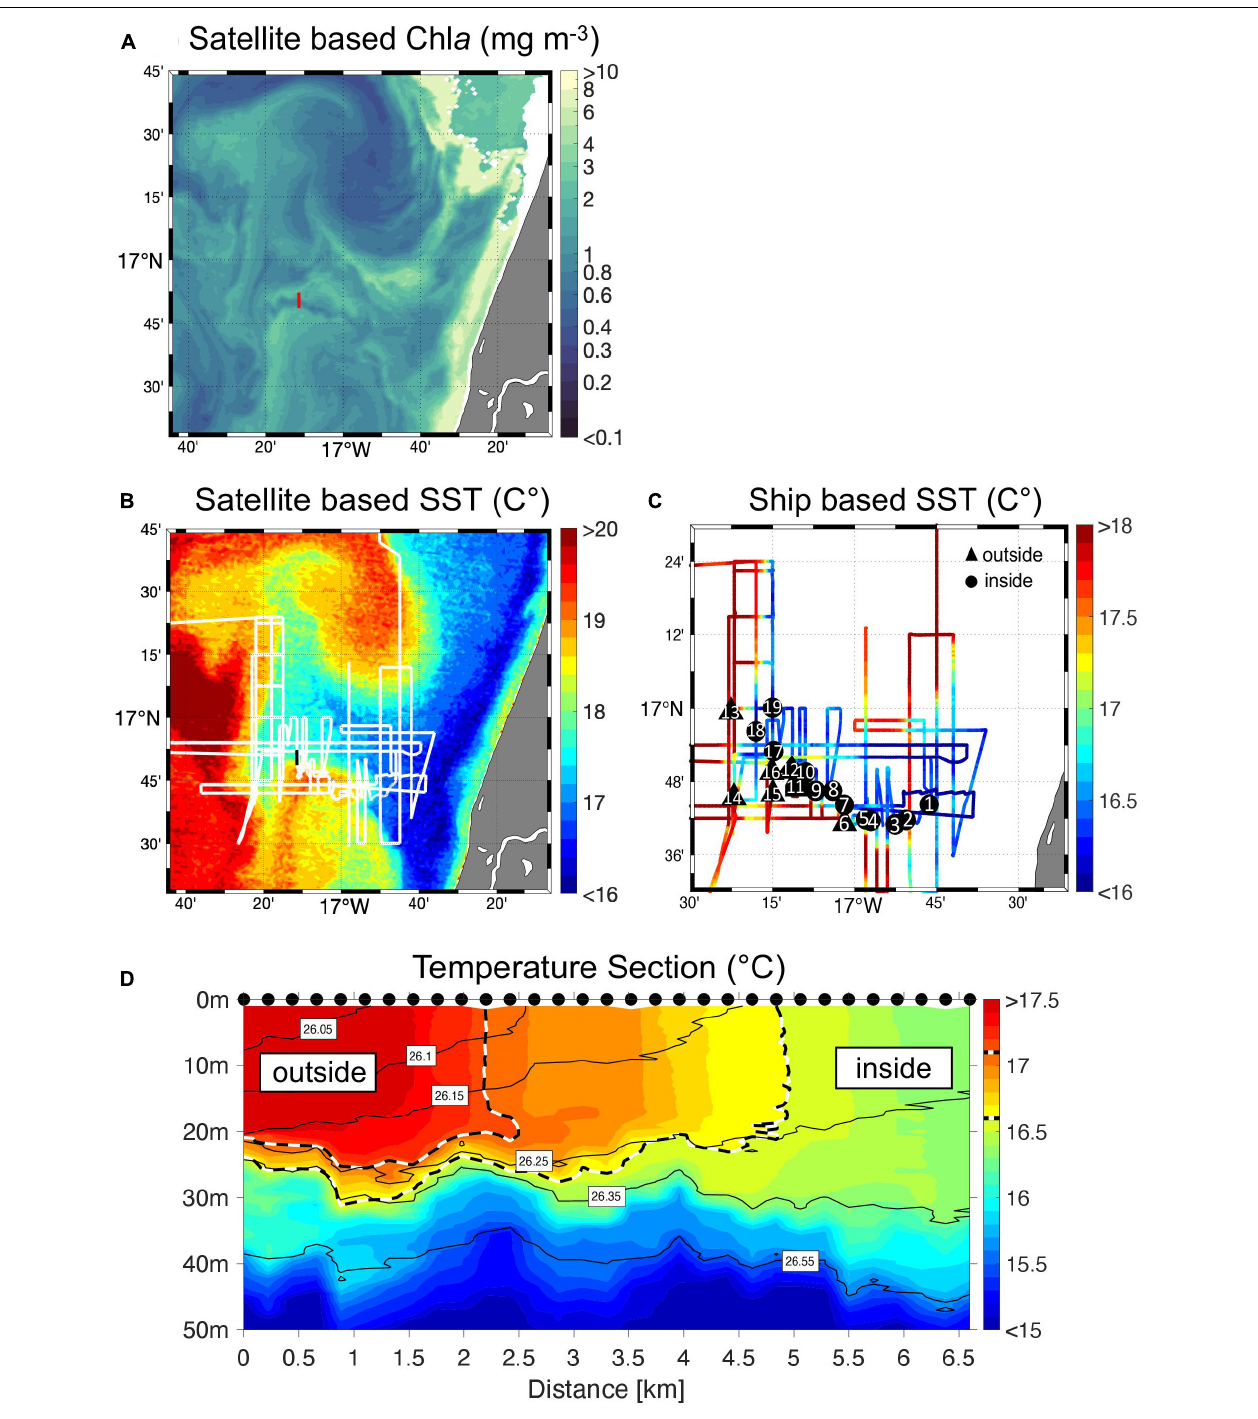
FIGURE 2 | Filament survey. Satellite image (25 January 2018) showing (A) Chl a concentration of the filament as provided by NASA and (B) sea surface temperature of the identified filament. The white line indicates the cruise track of RV Poseidon during sampling in January/ February 2018. The red and black lines indicate the position of the vertical temperature section shown in (D) . (C) Cruise track depicted in surface water temperature as measured from the ship at 2 m depth. Sampling stations along the filaments edge are marked either as black circles inside or as triangles outside the filament. Note that (C) is different in scaling than (A,B) . (D) The temperature cross-section against depth, as performed on 2 February 2018, reveals a clear separation between cold, upwelling water masses inside ( ≤ 16.5 ◦ C) and warmer, stratified waters ( ≥ 17.1 ◦ C) outside the filament (the boundaries are marked by the dashed black/white lines). The grey lines indicate potential density layers. Black dots mark the actual position where the microstructure measurements were